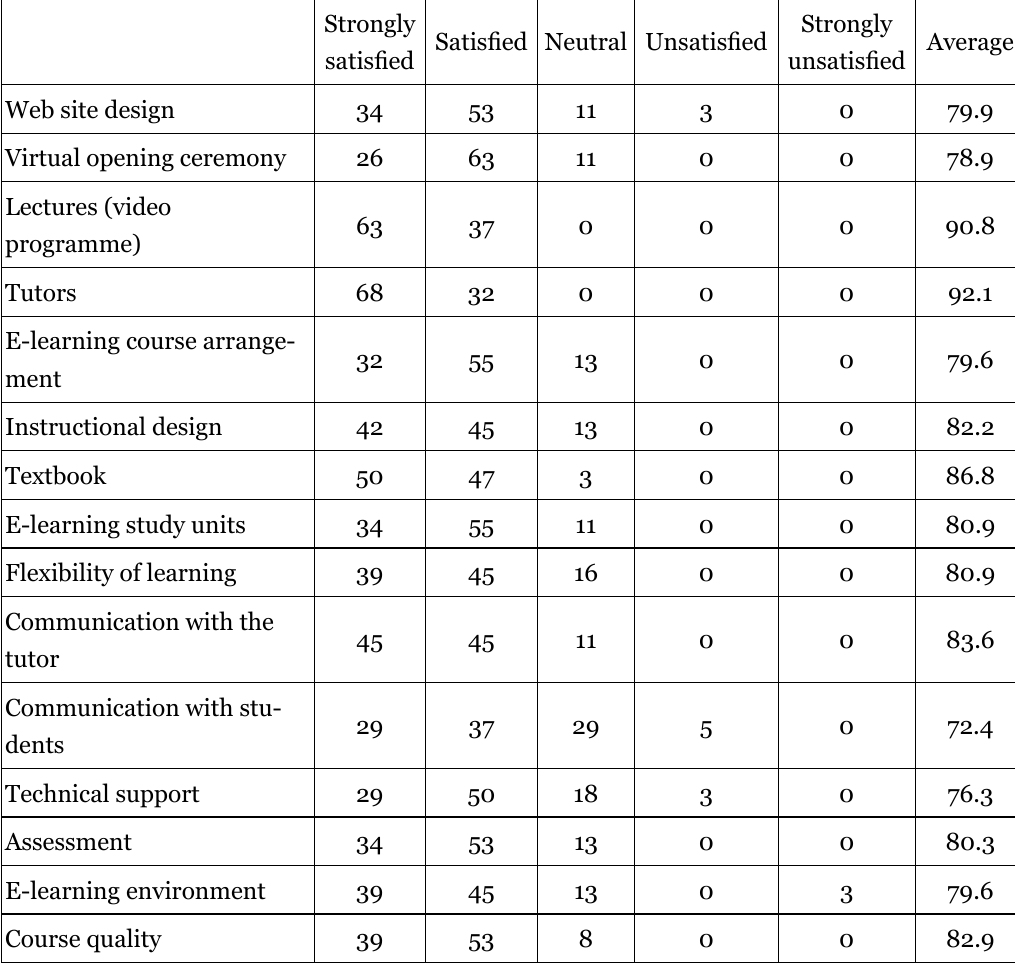
Students’ Degree of Satisfaction with the E-Learning Course (%) Strongly Satisfied Neutral Unsatisfied satisfied